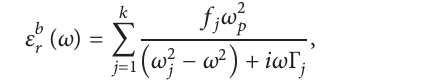
Figure 1: Block diagram of